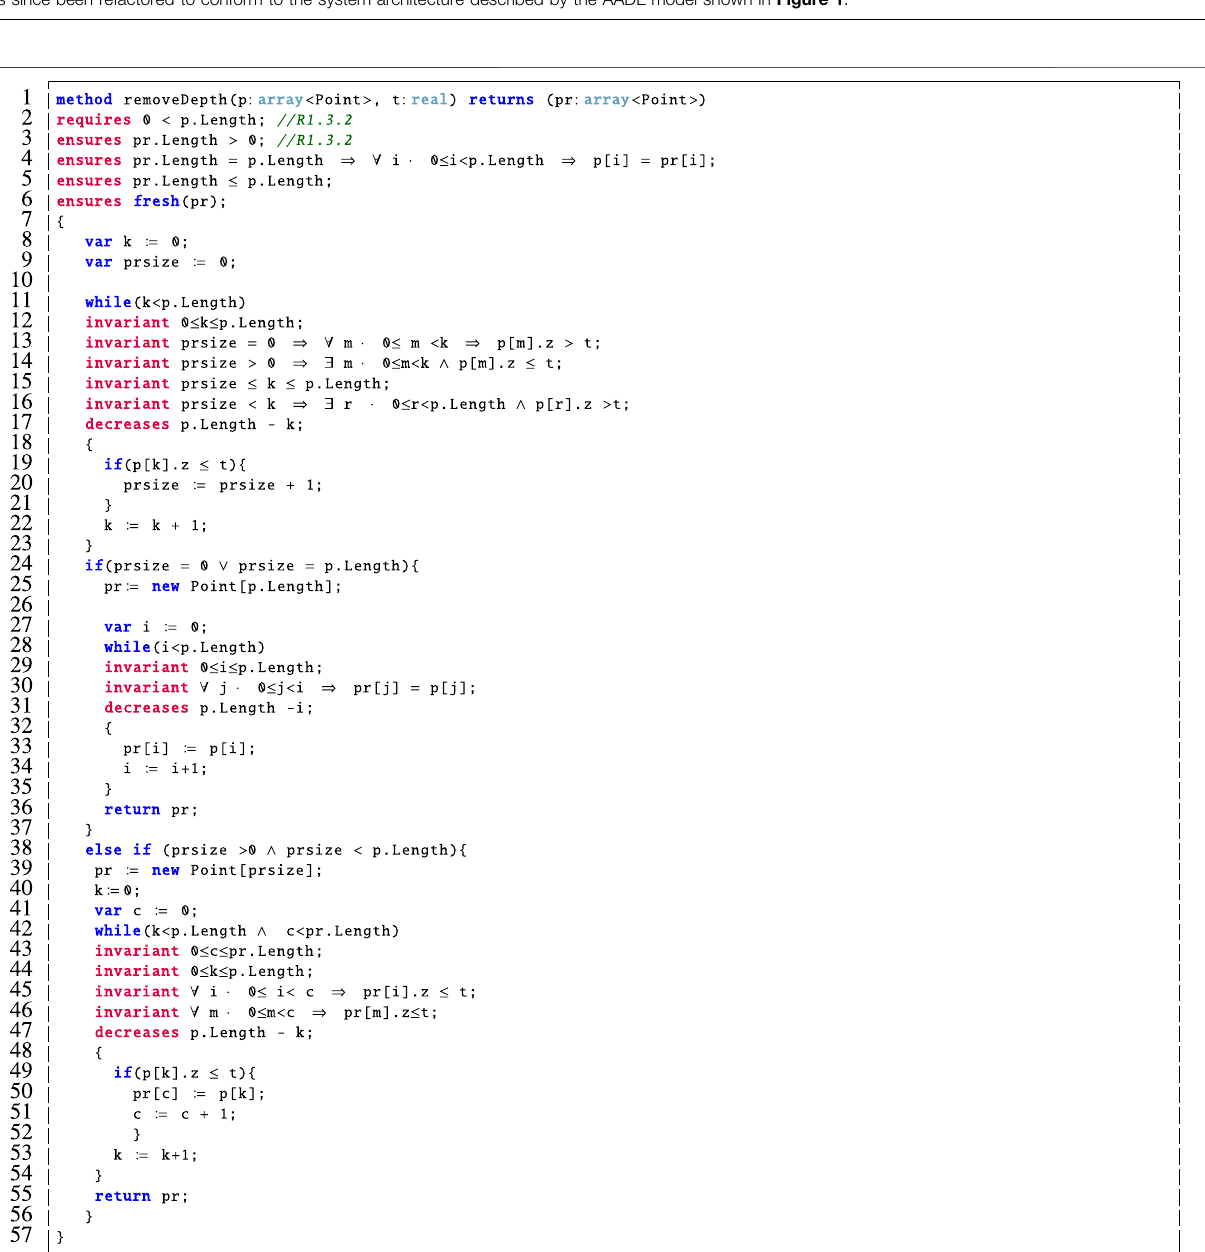
Frontiers in Robotics and AI |